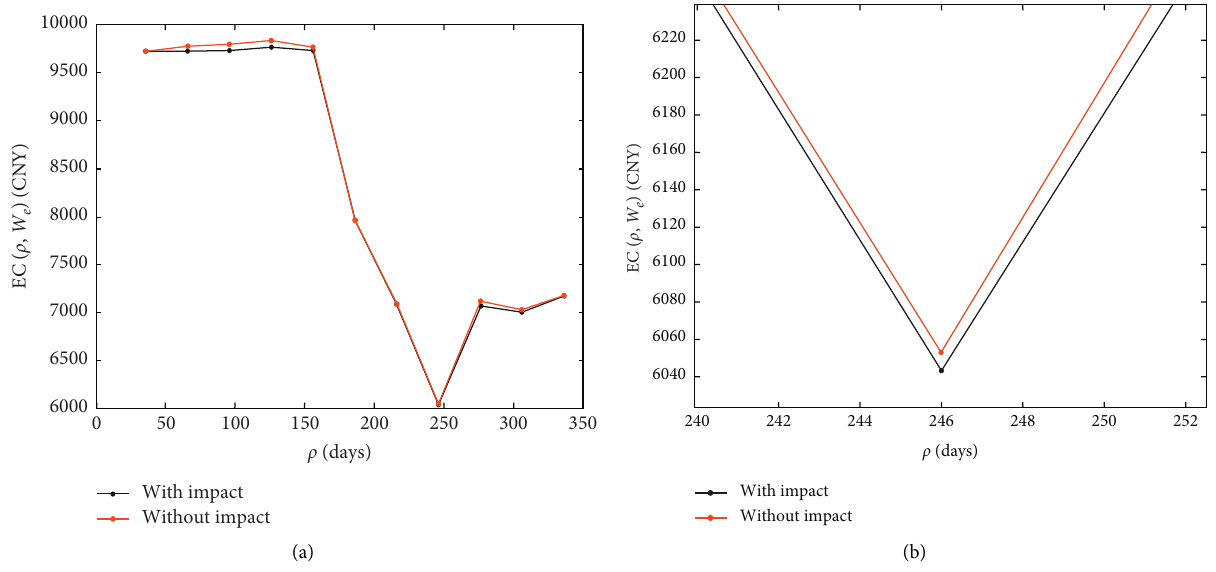
Figure 12: (a) The comparison of the above two situations. (b) Partial enlarged view of the lowest EW